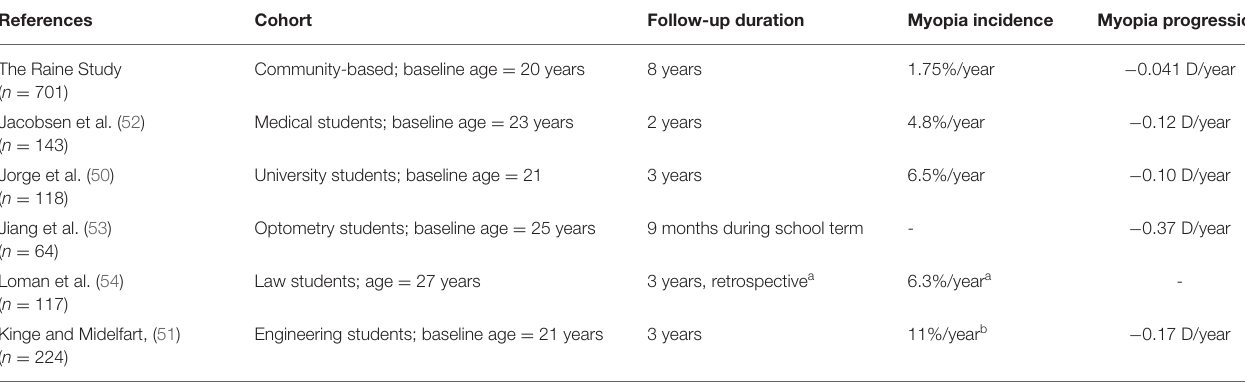
TABLE 1 | Myopia incidence and progression in young adults, as reported by previous